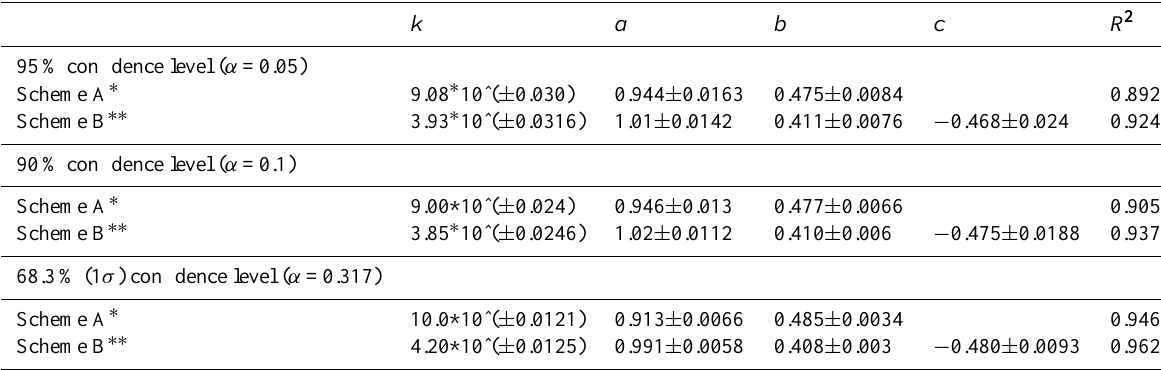
Table 3. Summary of Regression coefficients for the two parameterization schemes at specific confidence levels; see Eqs. (12) and (14) of Sect. 4.4 for description.